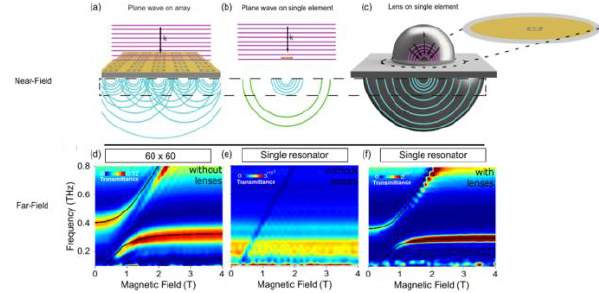
Fig. 2. Schematic views of the near field interaction between the THz field and (a) an array of cSRRs (b) a single cSRR without lenses, and (c) a single cSRR with lenses. (d)-(f) show the colormaps corresponding to the normalized transmittances of cSRRs on top of a GaAs quantum well measured under a varying B-field from 0-4T with the same lens